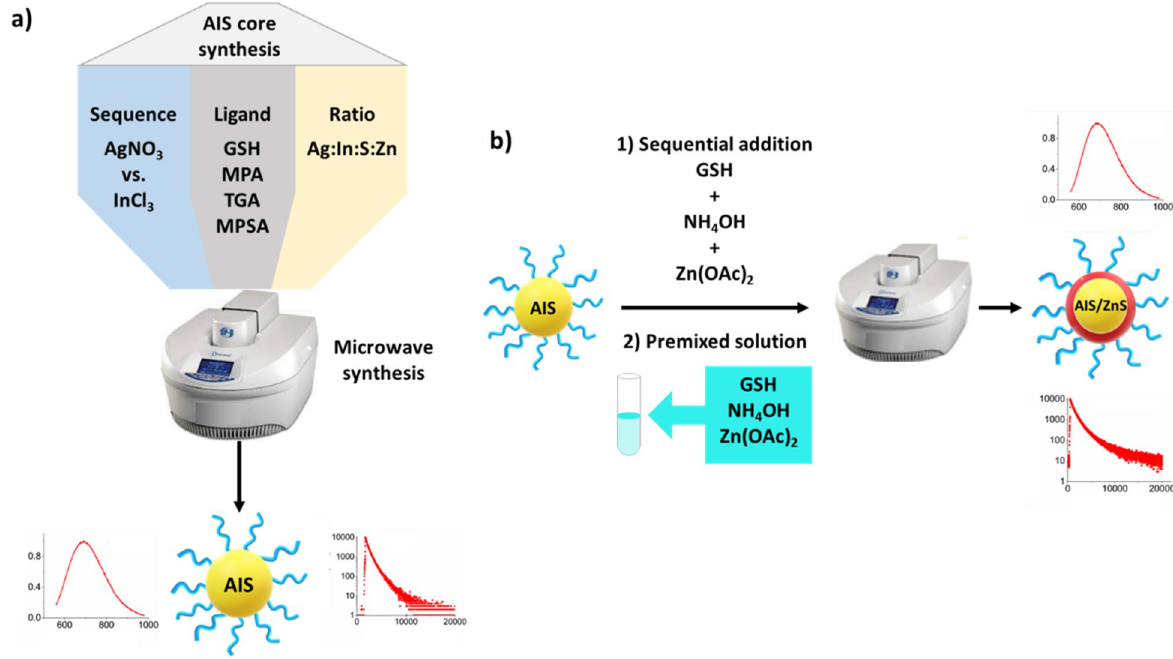
Figure 1. Overview of the different procedures ( C1 and C2) as well as varied synthesis parameters for the AIS core preparation (panel a ) and the schematic presentation of the core/shell synthesis using a sequential addition of reagents ( CS1 ) or a premixed solution ( CS2 ) (panel b